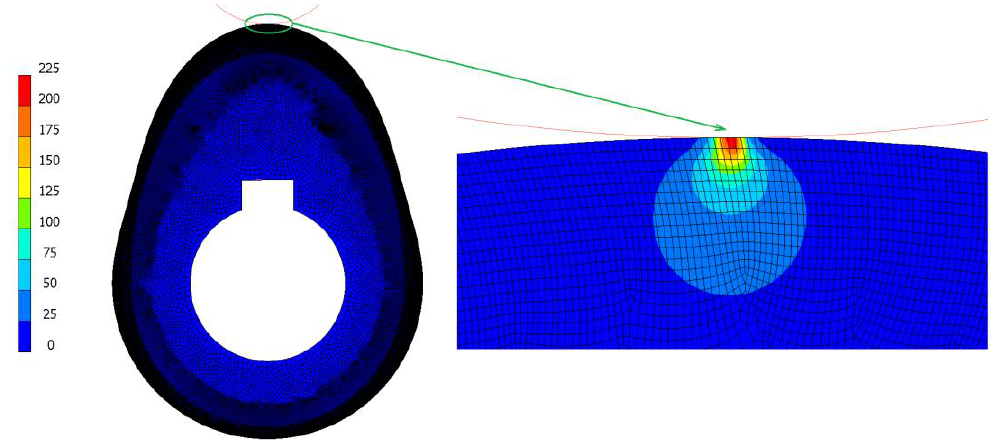
Figure 11. Equivalent Von-Mises stress (MPa) at the top dead centre.